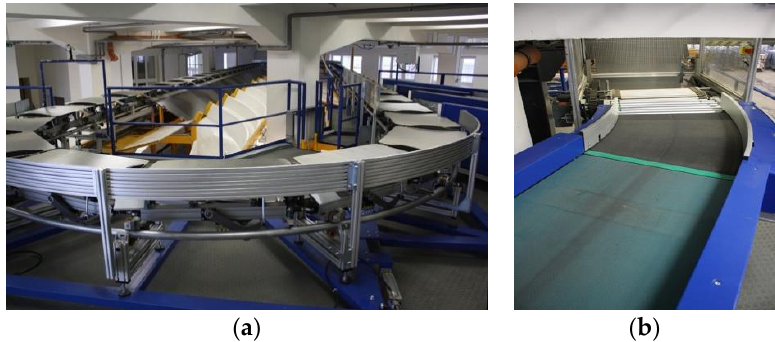
Figure 1. ( a ) Sample sorting line; ( b ) fragment of the conveyor belt in the sorting line.